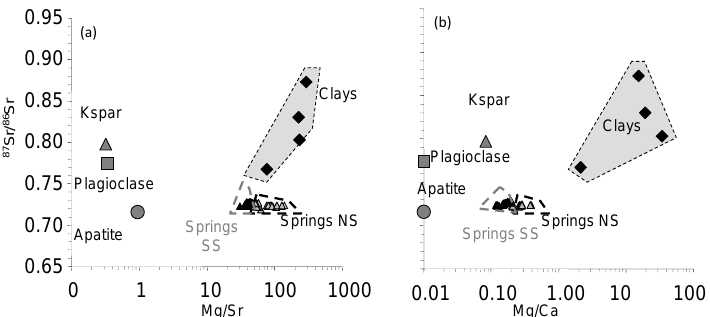
Figure 8. 87 Sr / 86 Sr vs. Mg / Ca (a) and Mg / Si (b) for the spring waters (NS = northern slope and SS = southern slope), primary minerals of the granite (Aubert et al., 2001) and clays from soils (Prunier, 2008).